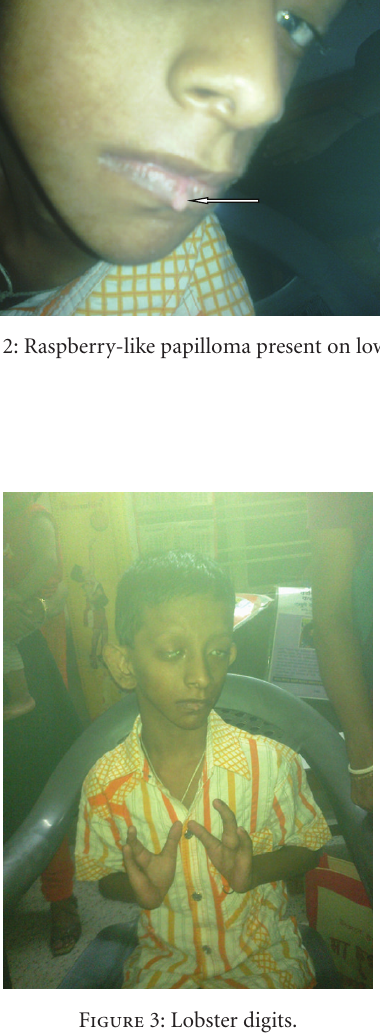
Figure 3: Lobster